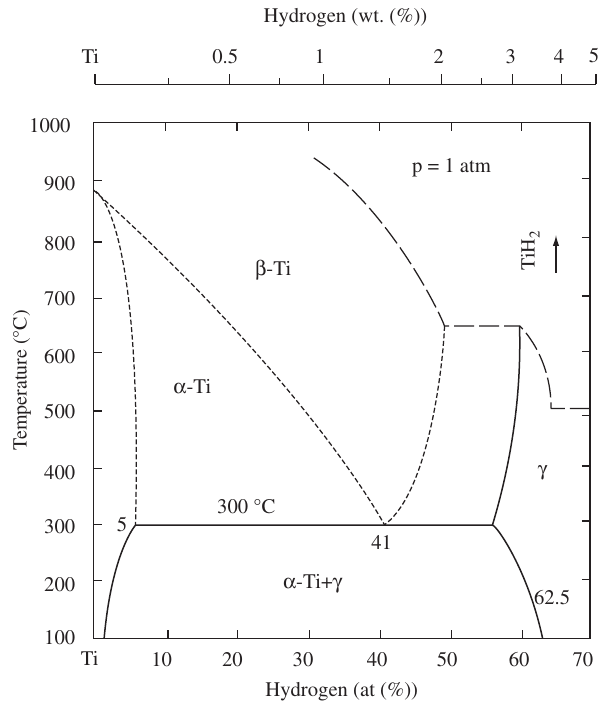
Figure 1. Ti-H phase diagram at P = 1